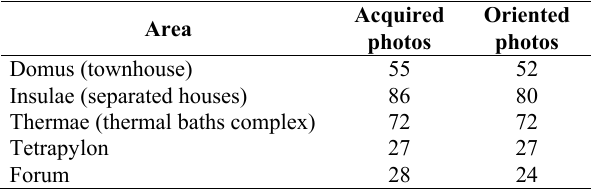
Table 4. Image distribution.